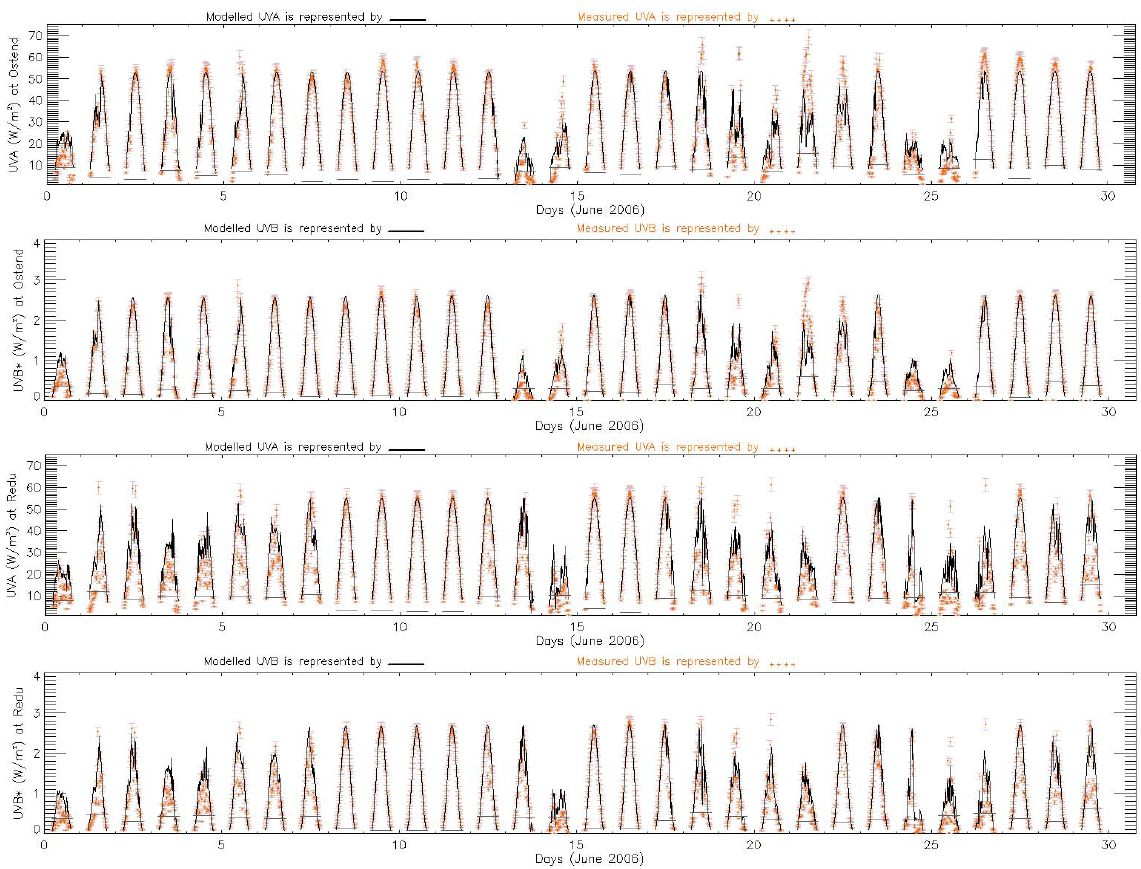
Fig. 6. Time series of modelled (solid lines) and measured (orange symbols) UV-A (a) and UV-B (b) irradiance over Ostend and UV-A (c) and UV-B (d) irradiance over Redu for the month of June